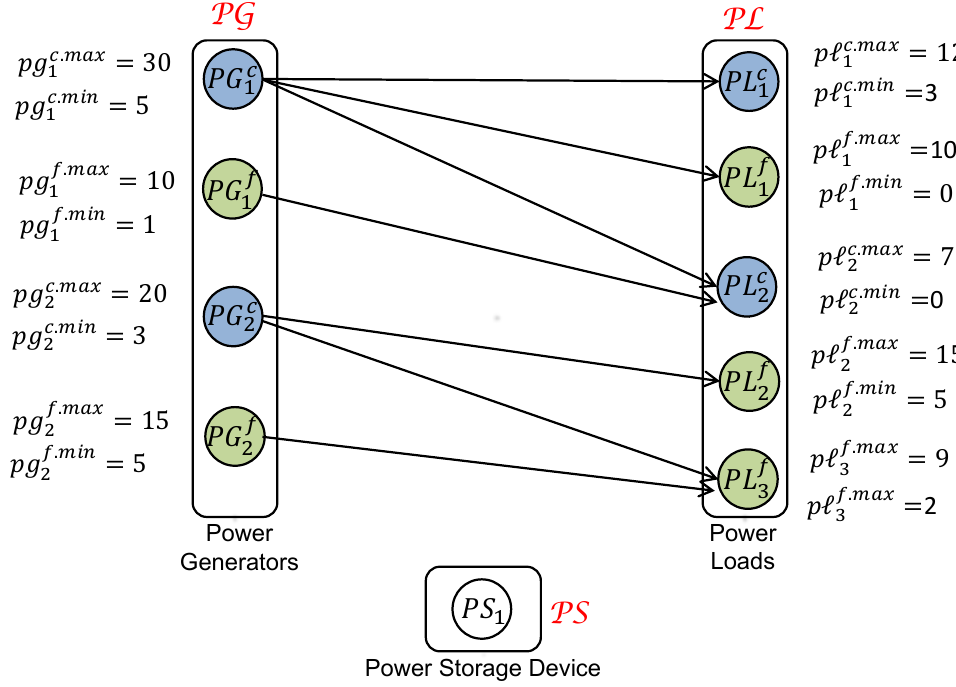
Figure 11. Example demonstration when generators and loads are not supported by any storage device.